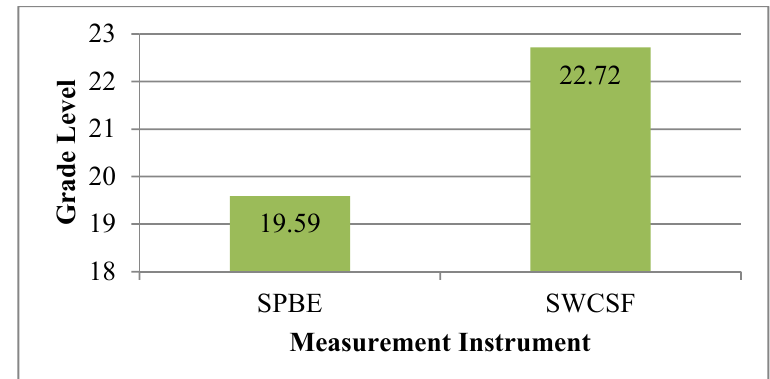
Figure 2. Grade Level of SPBE and